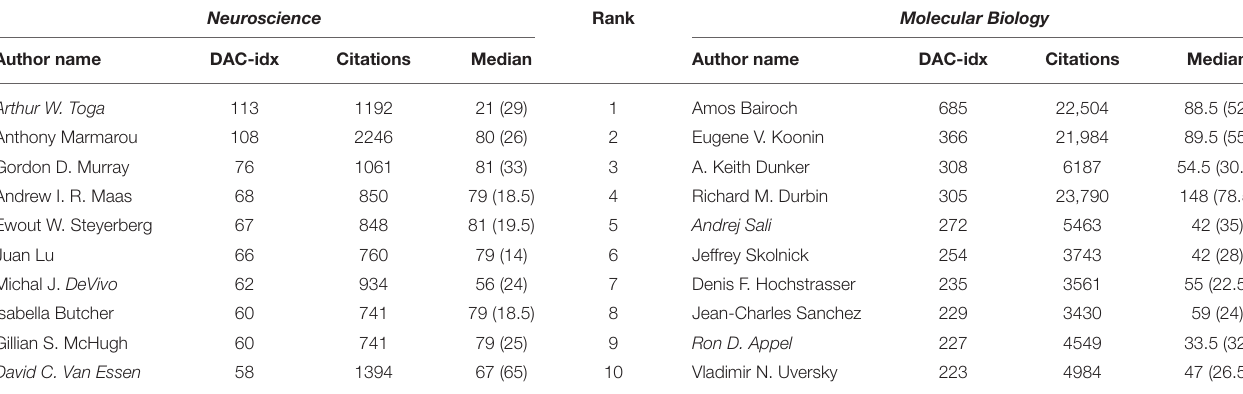
TABLE 1 | DAC-index ranking for the top 10 neuroscience (left) and molecular biology (right) authors. Neuroscience Rank Molecular